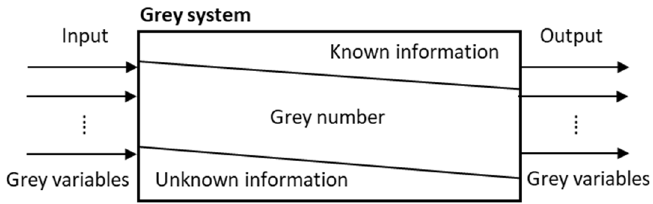
Figure 2. The framework of grey system